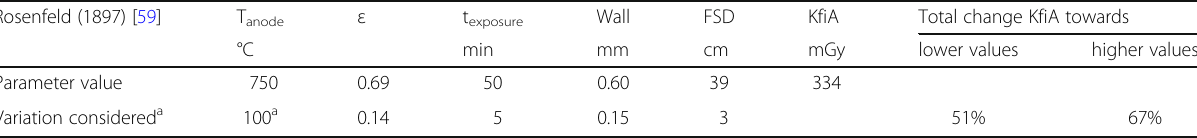
Table 6 Sensitivity of the KfiA to basic parameters for an 1896 X-ray tube with glowing anode Rosenfeld (1897) [59]